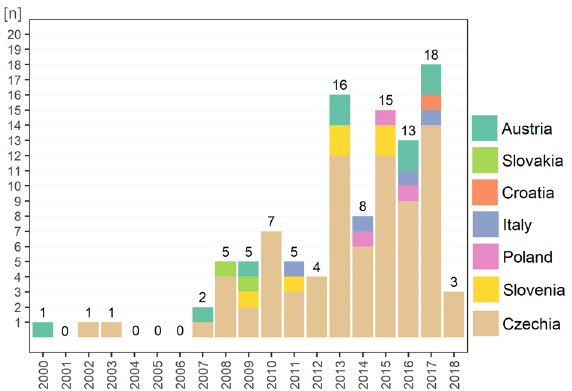
Fig. 1. Publication frequency and the localization of the